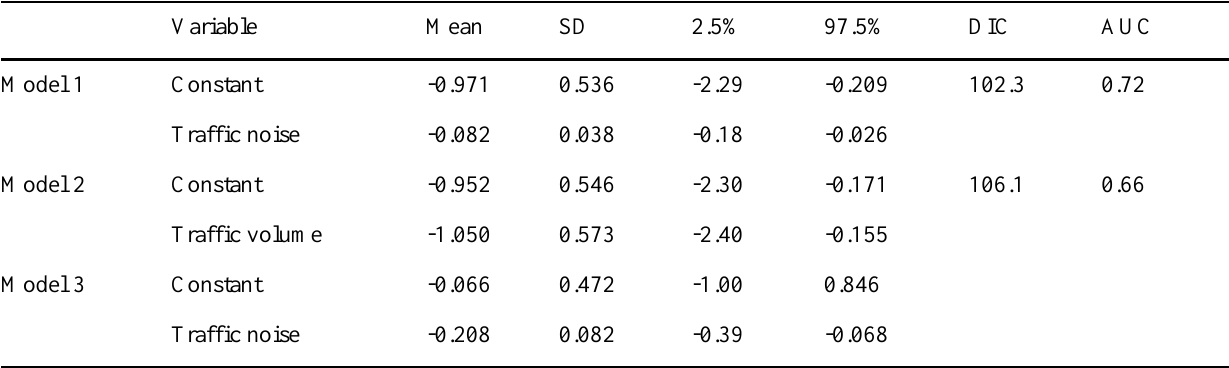
Table 3. Coefficients (Mean, SD, and 2.5th and 97.5th percentiles) of the variables included in the models of the probability of detecting the Grey Fantail on a visit to a site, as a function of traffic noise (Models 1 and 3) and traffic volume (Model 2), with the deviance information criterion (DIC) and receiver-operating characteristic curve (AUC) values for models 1 and 2. Models 1 and 2 include data from all 58 study sites, whereas Model 3 includes data from the 19 study sites in which traffic volume was < 200